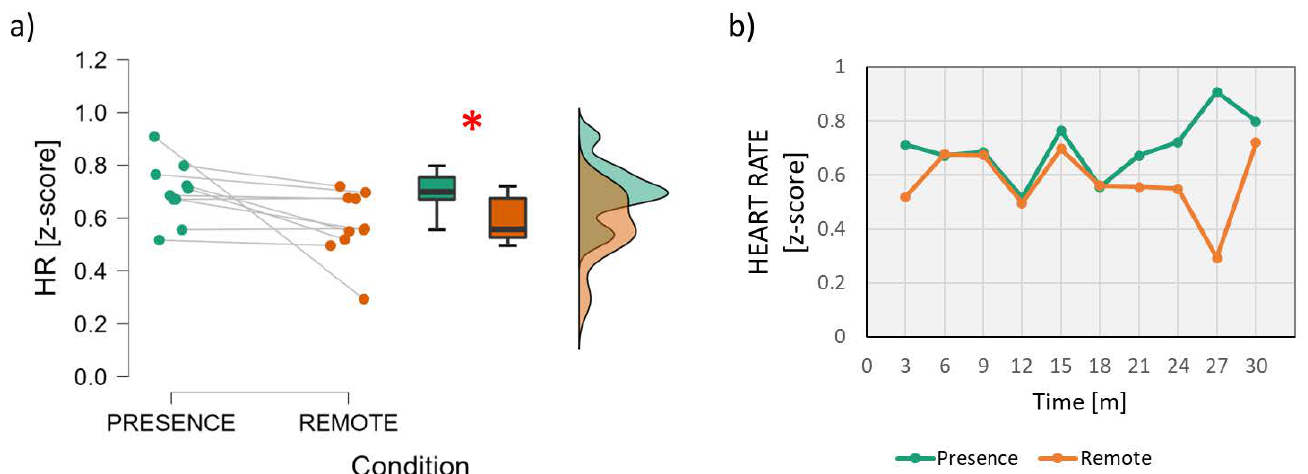
Figure 4. Analysis of the Heart Rate parameter. On the left ( a ), mean and confidence interval (95%) of the distributions related to the two conditions (In-presence and Remote). The red asterisk indicates the presence of a statistically significant effect. On the right ( b ), the dynamics of the HR averaged across students during the time span of the lesson. The red asterisk indicates the statistically significant ( p < 0.05) result.